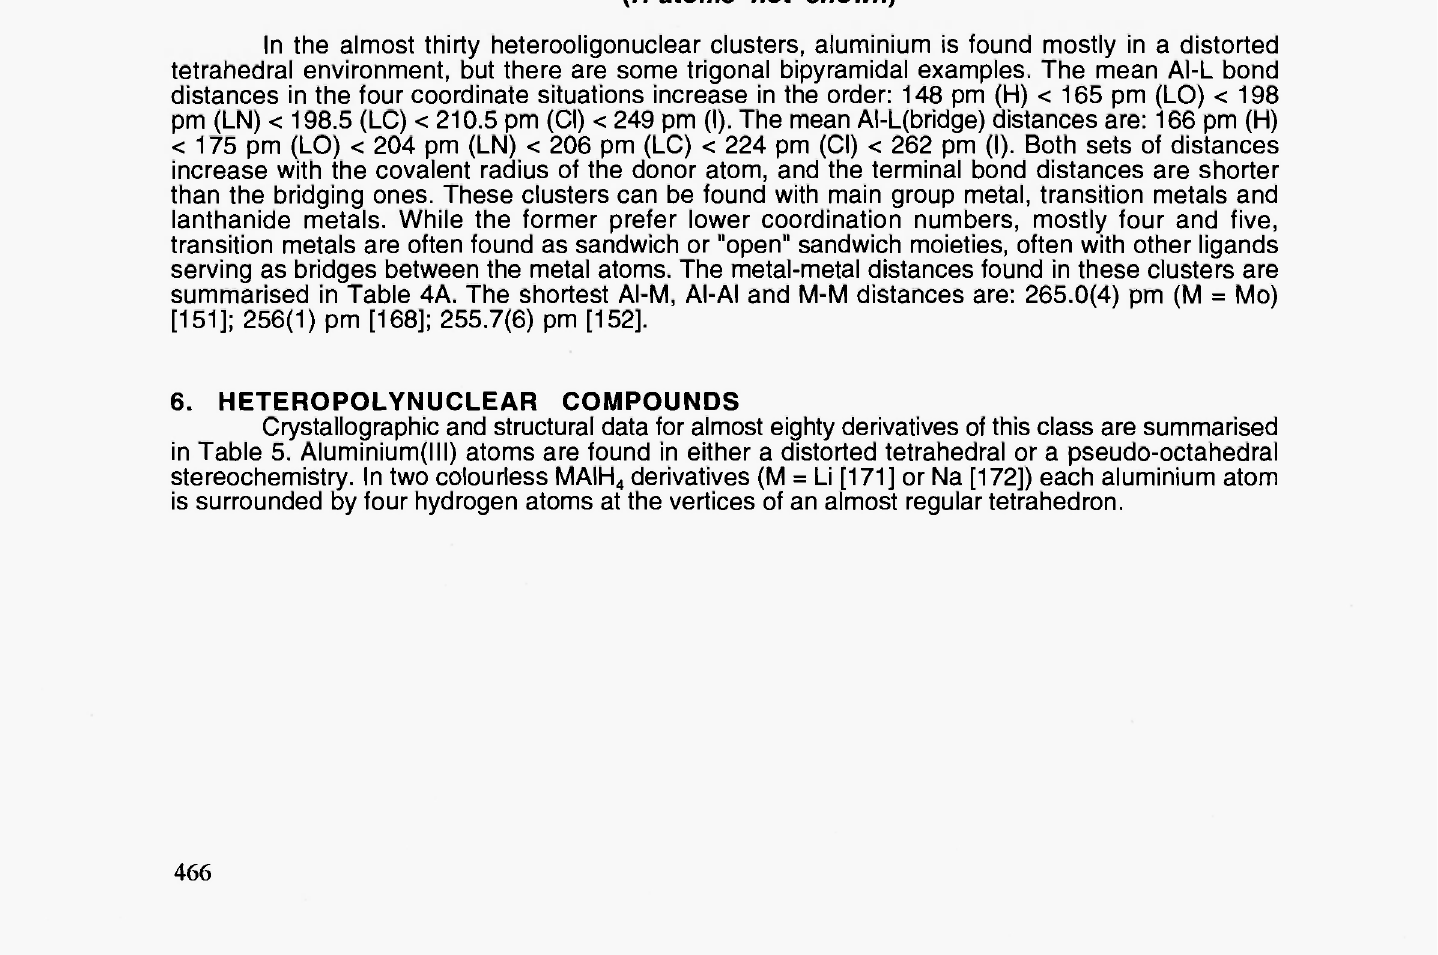
AI Me (CH2)2 [138] 3 6 8